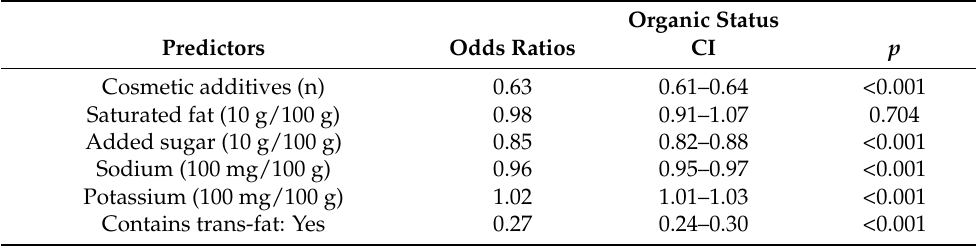
Table 4. Results from mixed logistic regression model of 8240 organic and 72,205 conventional prod- ucts including the imputed missing data. This model included the parameter “cosmetic additives”.